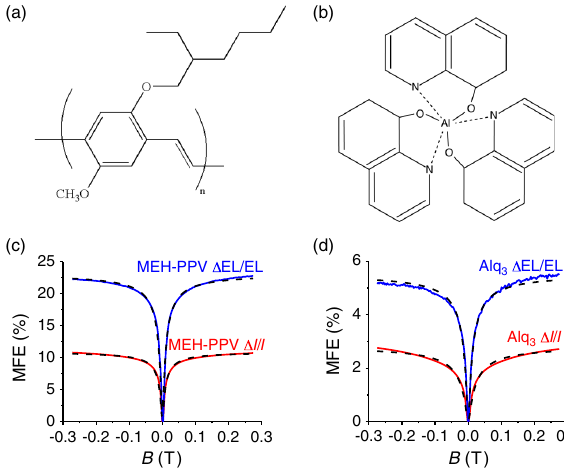
FIG. 3. Molecular structures of (a) MEH-PPVand (b) Alq 3 that have been used in control experiments. Typical magnetconduc- tance (red line) and magnetoelectroluminescence (blue line) in (c) MEH-PPVand (d) Alq 3 control devices that are dominated by exciton emission. The dashed black lines represent fits to the non-Lorentzian line shape (see